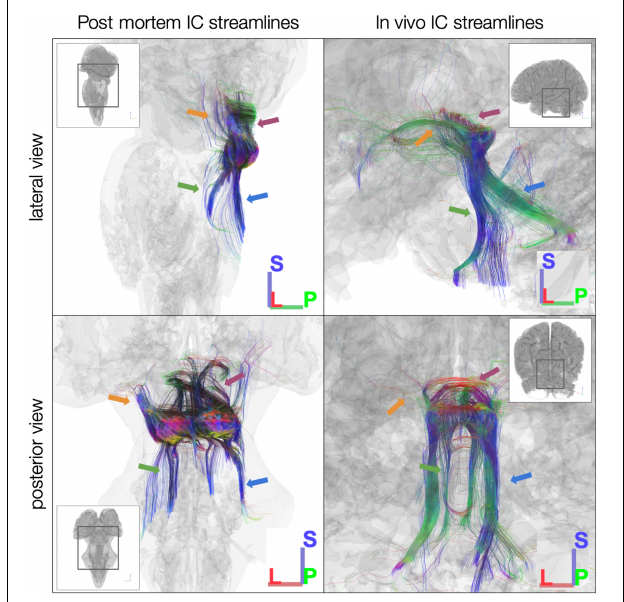
FIGURE 3 | Diffusion MRI tractography streamlines passing through left and right inferior colliculus (IC). Colors represent local streamline orientation: blue, superior–inferior; red, left–right; green, anterior–posterior. Insets show entire specimen or brain surface. Left: post mortem dataset. Right: in vivo MGH 760 µ m dataset. Both datasets demonstrate canonical auditory pathways (green arrows, lateral lemniscus; orange arrows, brachium of IC) as well as non-primary auditory connections [for instance, to superior colliculus (magenta arrows) and through cerebellar peduncles (blue